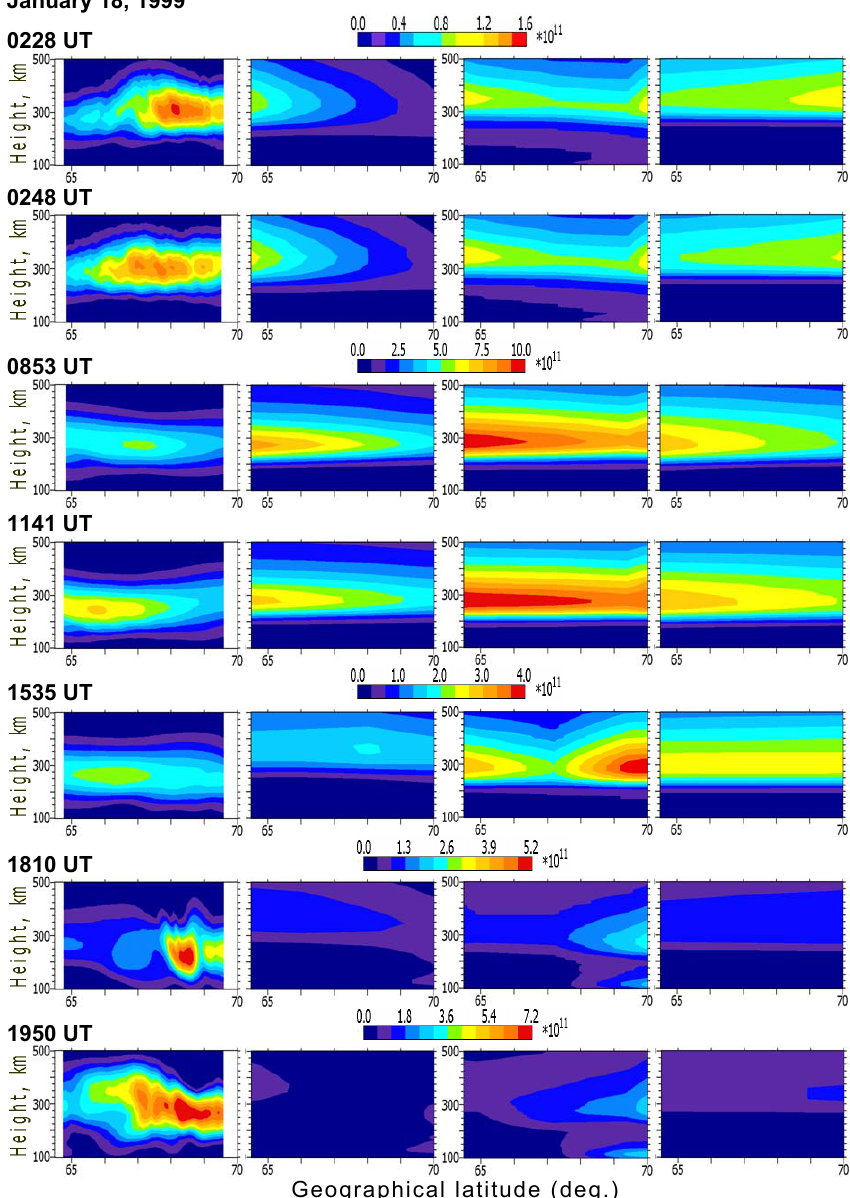
Fig. 4. Same as Fig. 3, on 18 January